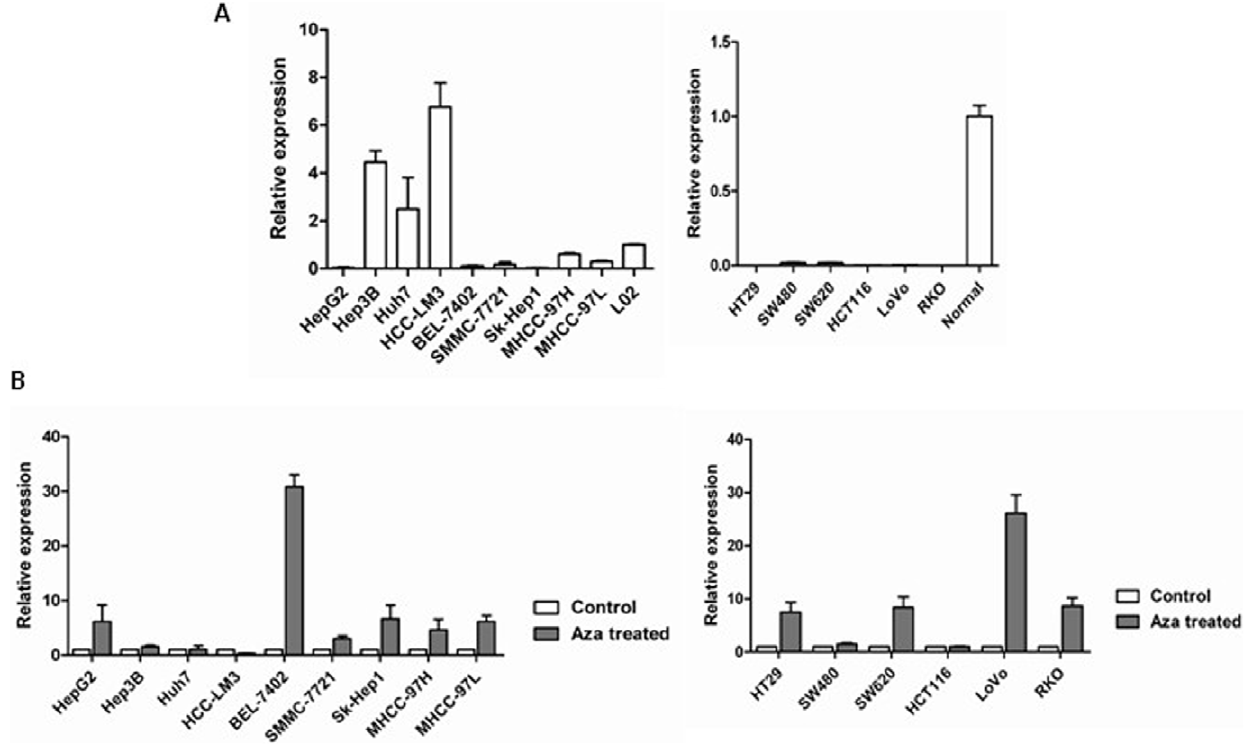
Figure 1. Pharmacological demethylation reversed FBP1 downregulation in human liver and other digestive cancers. ( A ) FBP1 expression in human liver and colon cancer cell lines and normal controls were determined by Real-Time RT-PCR. GAPDH was used to normalize the template amount. ( B ) Relative FBP1 expression before and after Aza treatment were determined by Real-Time RT-PCR. GAPDH was used to normalize the template amount. It was shown as average fold changes 6 SD.